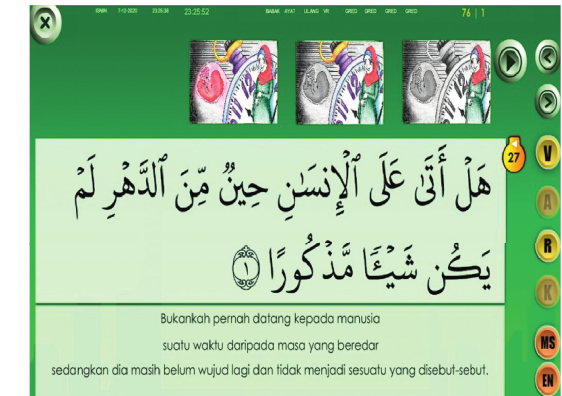
Figure 6: VARK Memorization interface showing only “V” and “R” modes being activated.